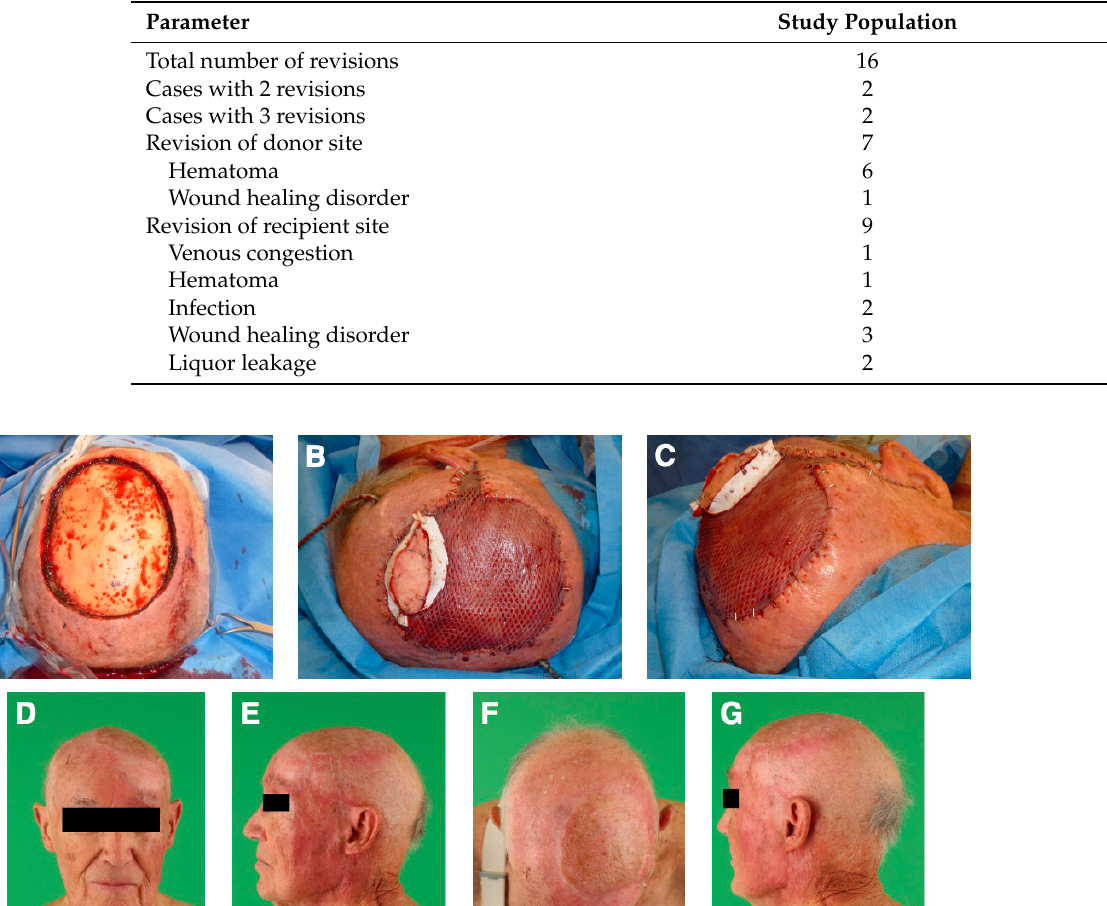
Table 4. Revision surgeries.